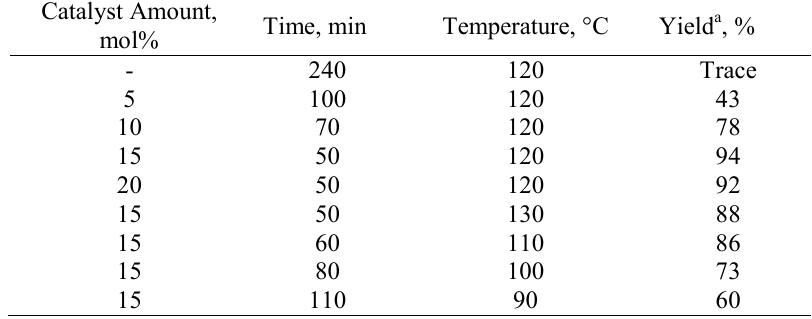
Table 3. Effect of amount of SaSA and temperature on the condensation of 2-naphthol with 4-methoxybenzaldehyde.